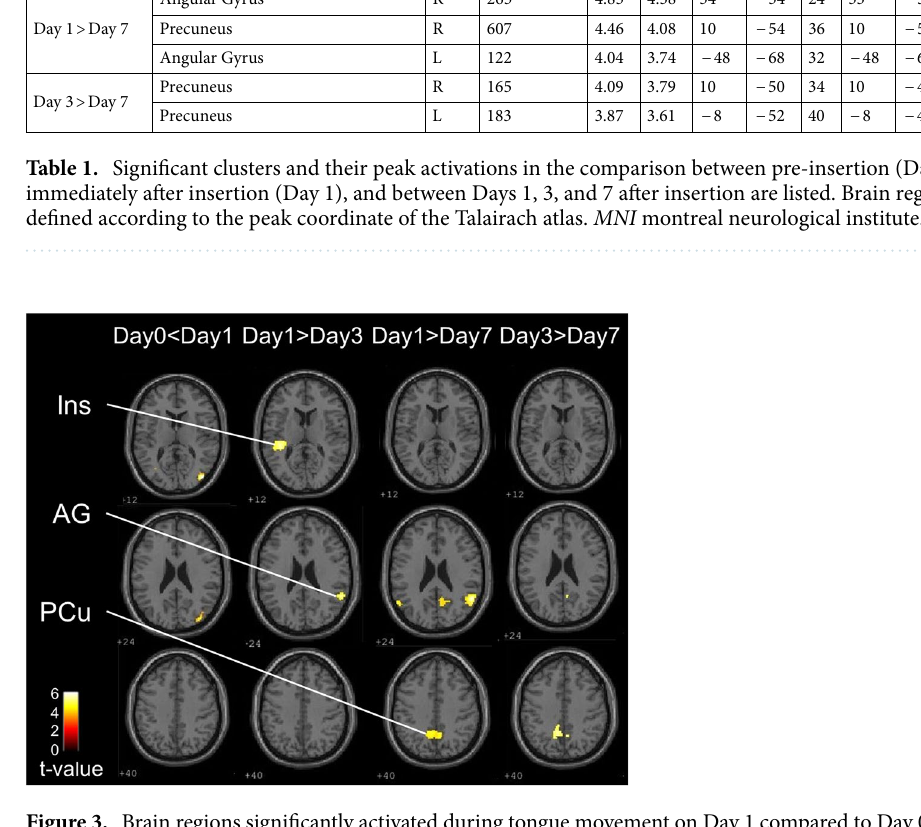
Figure 3. Brain regions significantly activated during tongue movement on Day 1 compared to Day 0, Day 3, and Day 7, and on Day 3 compared to Day 7 (n = 27) implemented in SPM12. Ins: insula; AG: angular gyrus; PCu: